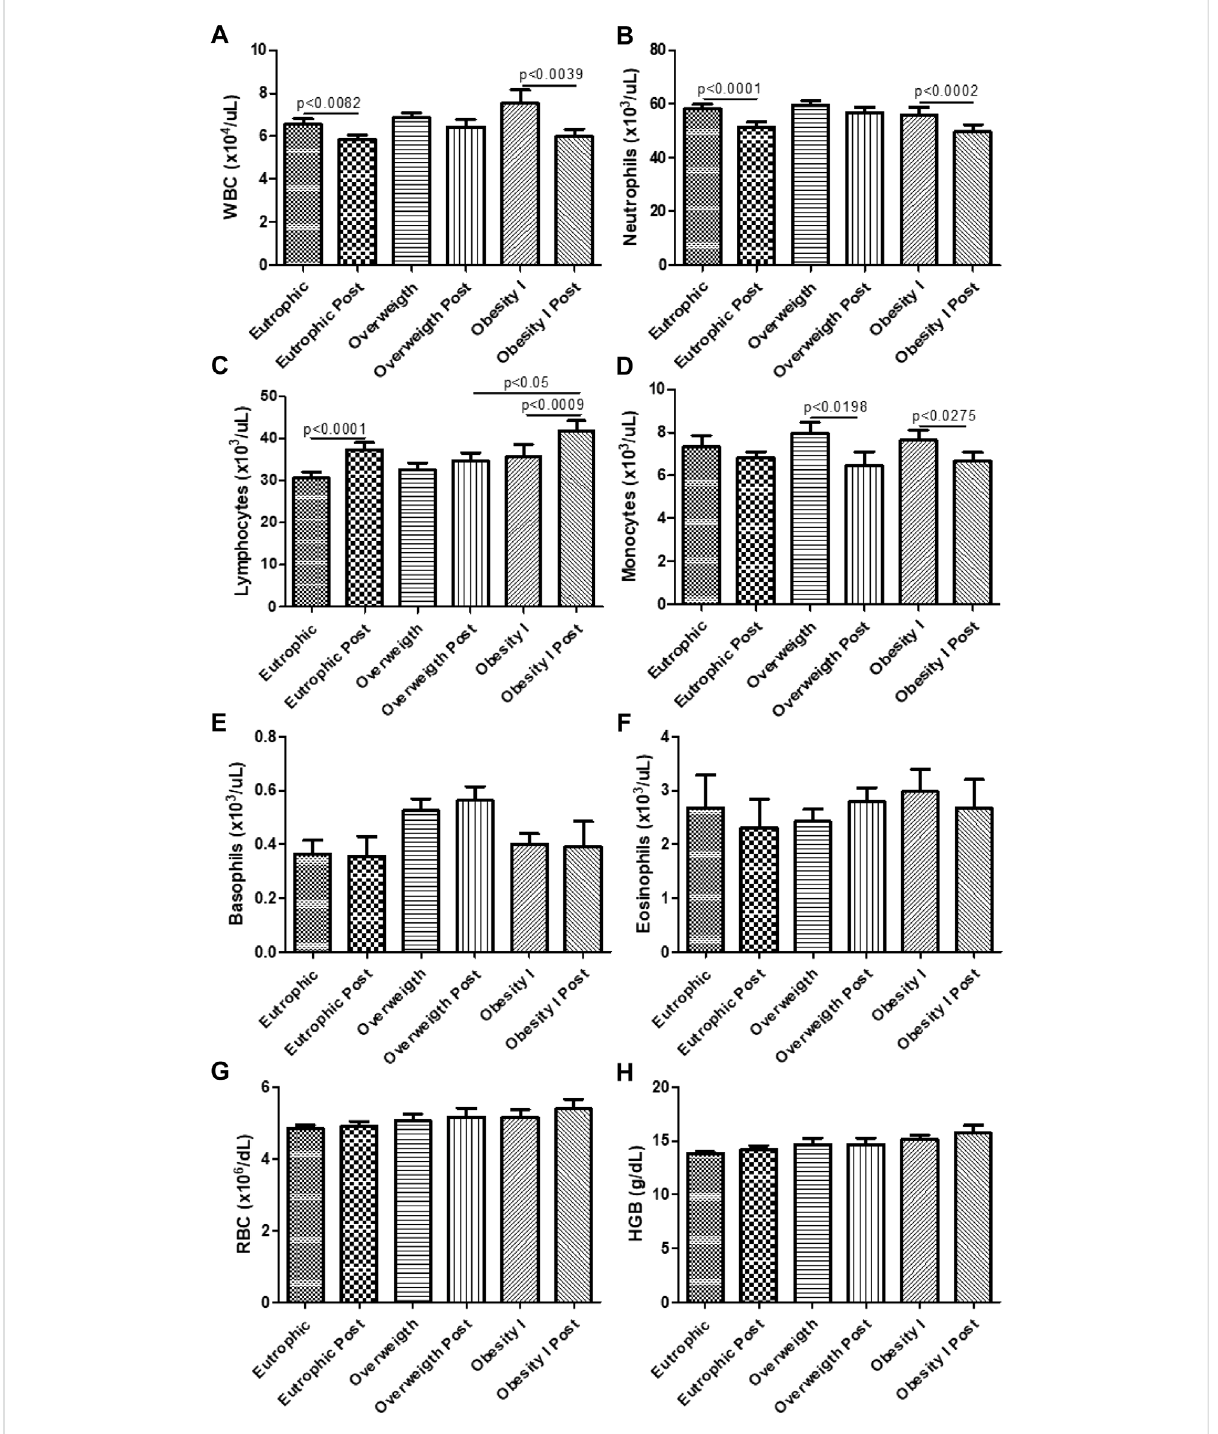
FIGURE 6 Effects of combined training on the systemic cellular immune response. Figure 6A shows the number of total leukocytes (white blood cells — WBC). Figure 6Bshows thenumber ofneutrophils.Figure 6C shows thenumberof lymphocytes. Figure 6D shows thenumber of monocytes. Figure 6E shows the number of basophils. Figure 6F shows the number of eosinophils. Figure 6G shows the number of red blood cells (RBC). Figure6Hshowsthenumberofglycatedhemoglobin(HBG).Paired t -testwasperformedtocomparethepre-andpost-effectsofrehabilitation (i.e., eutrophic non-obese pre x eutrophic non-obese post; overweight pre x overweight post; obesity I pre x obesity I post). A p < 0.05 was considered statistically signi fi cant. These data presented parametric distribution and were additionally evaluated using one way ANOVA followed by the Newman – Keuls test for multiple comparisons among the